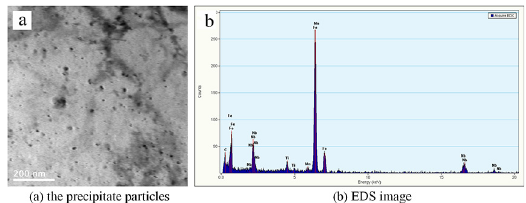
Figure 11. TEM micrograph of specimen B-2 showing the presence of carbonitrides